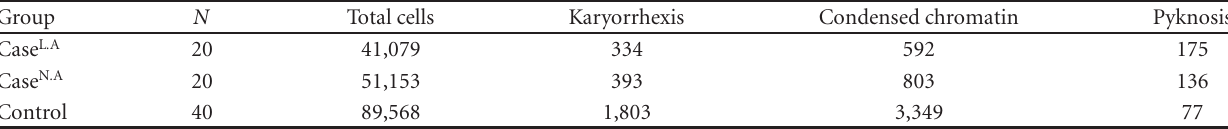
Table 4: Degenerative nuclear alterations indicative of apoptosis observed.